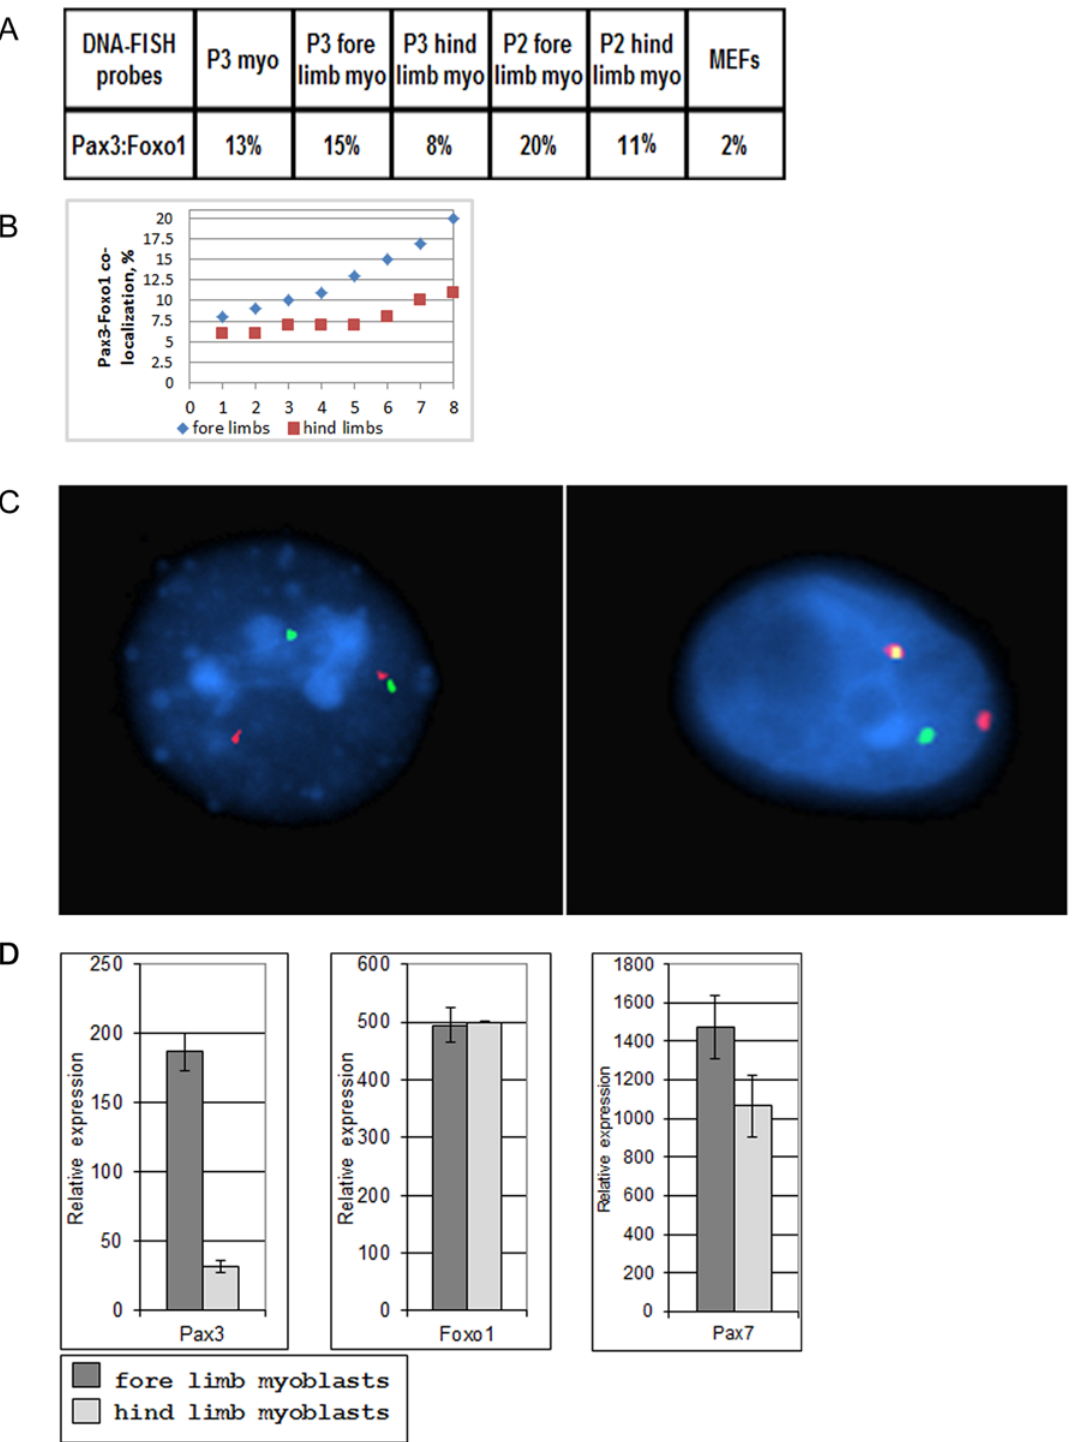
Figure 1. Co-localization of Pax3 and Foxo1 in primary mouse myoblasts. A. Percentages of Pax3 and Foxo1 co-localization in interphase nuclei of primary mouse myoblasts and MEFs as determined by FISH analysis using Pax3 and Foxo1 BAC probes. Myo = myoblasts; MEFs = mouse embryo fibroblasts. P2 and P3 represent the second or third passage of the myoblasts in culture, B. Compilation of eight independent Pax3 and Foxo1 co-localization experiments in interphase nuclei of primary fore limb and hind limb mouse myoblasts as determined by FISH analysis using Pax3 and Foxo1 BAC probes. Experiments1, 3, 5, 6, 7 and 8 were done with normal myoblasts, while experiments 2 and 4 were performed with Foxo1-inv+/+ myoblasts. This compilation